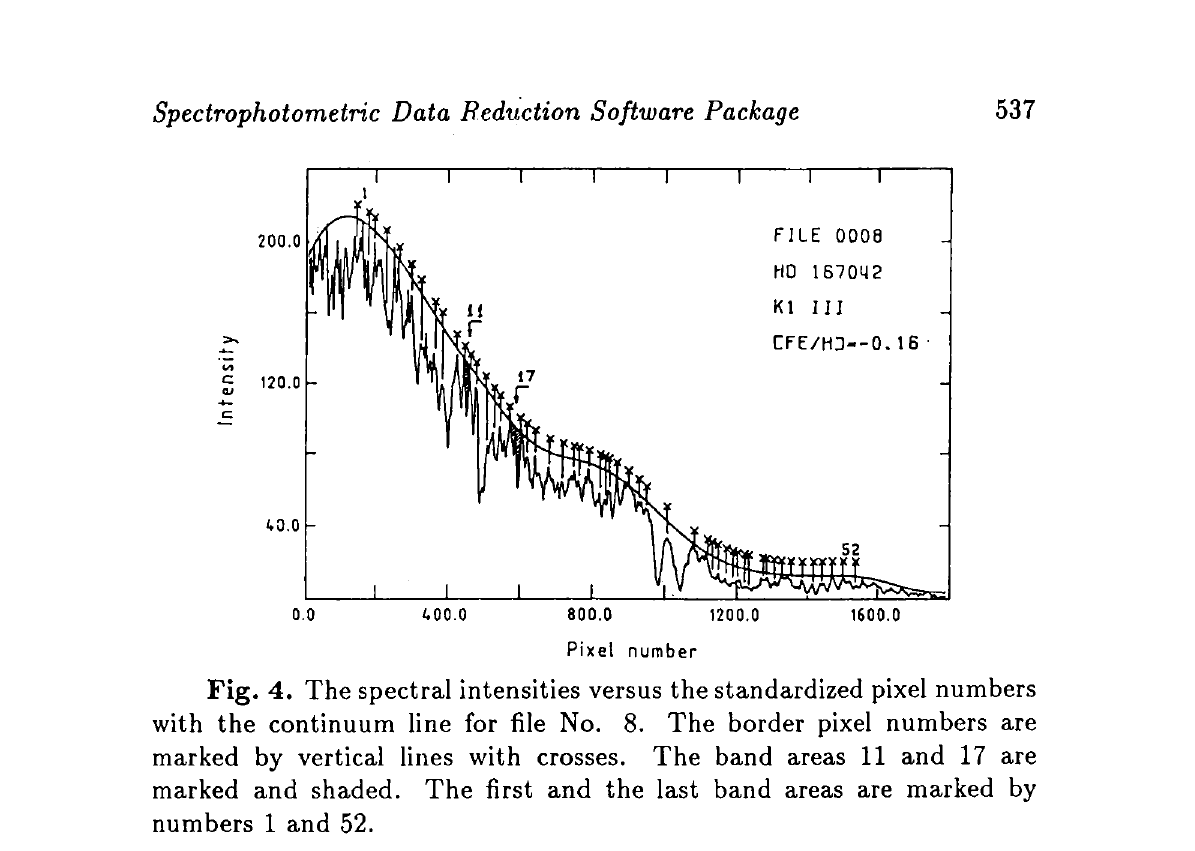
Fig. 4. The spectral intensities versus the standardized pixel numbers with the continuum line for file No. 8. The border pixel numbers are marked by vertical lines with crosses. The band areas 11 and 17 are marked and shaded. The first and the last band areas are marked by numbers 1 and 52.